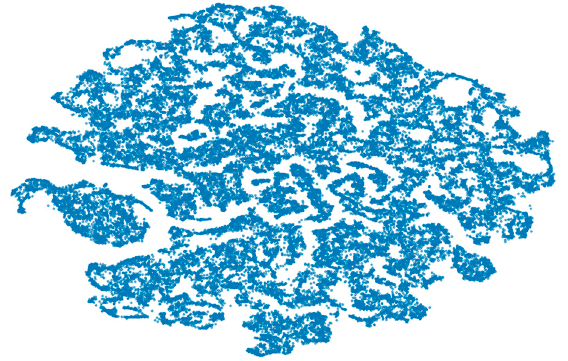
Figure 4. Color features of testing dataset sky images.